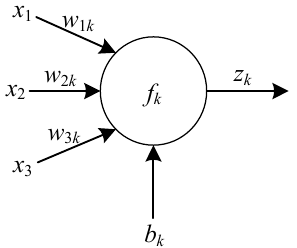
Figure 12. Working principle diagram of hidden layer neurons.